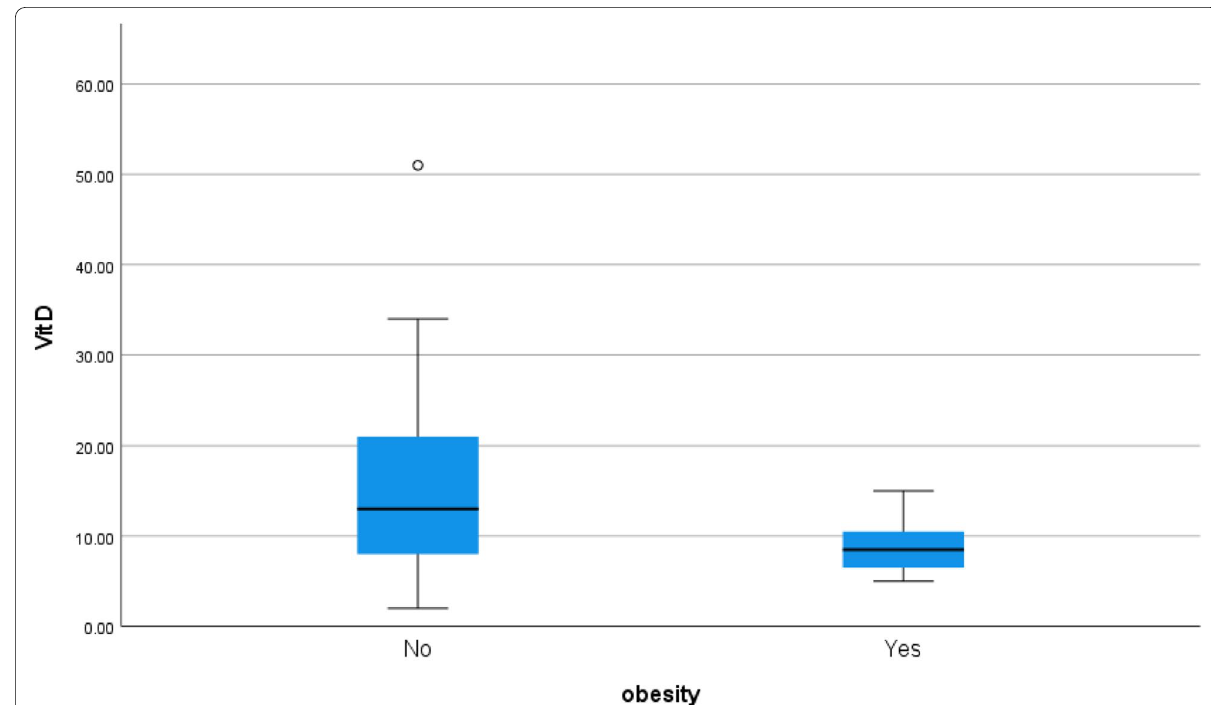
Fig. 19 Correlation between serum vitamin D level and obesity in COVID 19 patients (symptomatic and non-symptomatic)